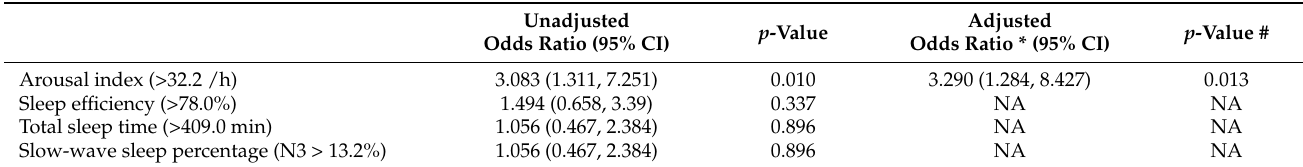
Table 2. Logistic regression models assessing the association between sleep measures and the presence of coronary